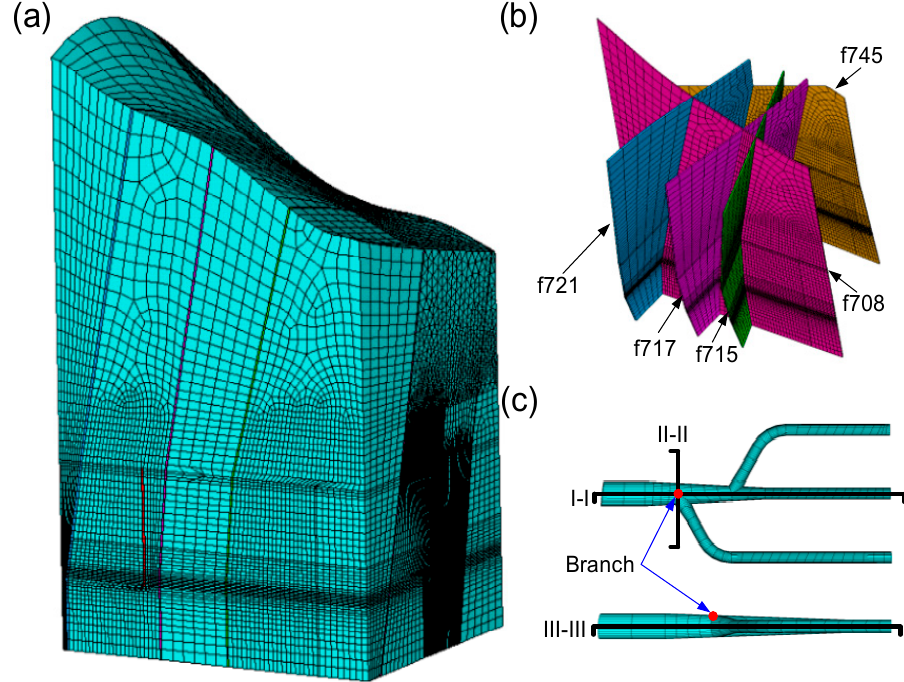
Figure 6. 3-Dfinite element (FE) of the study area: ( a ) finite element, ( b ) key faults, and ( c ) hydraulic tunnels.